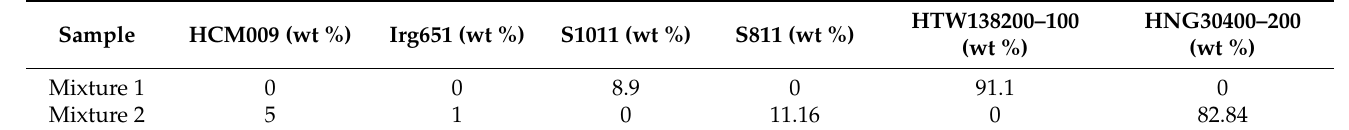
Table 1. The compositions of the samples studied.